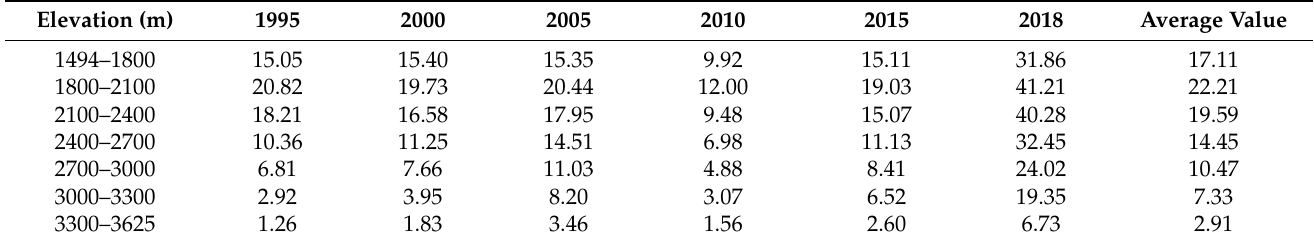
Table 2. Modulus of soil erosion in different years at different altitudes in the South and North Mountains of Lanzhou (unit: t/(km 2 ·